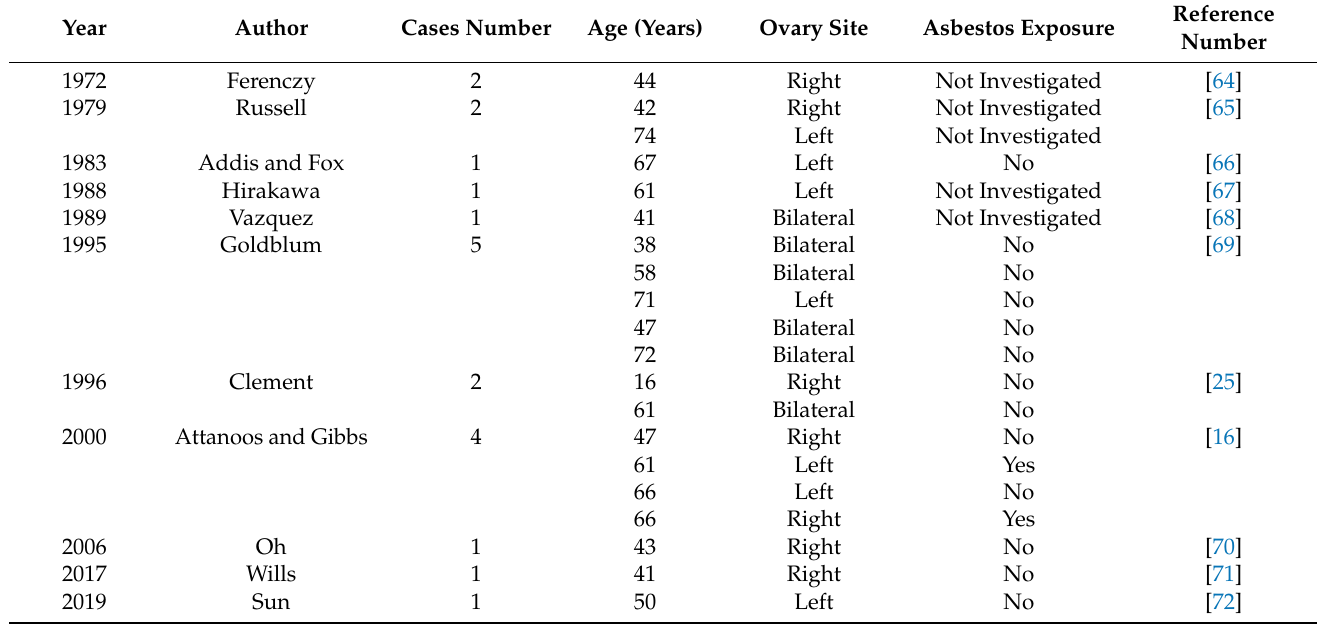
Table 3. List of the twenty-one “ovarian mesothelioma” cases reported in the